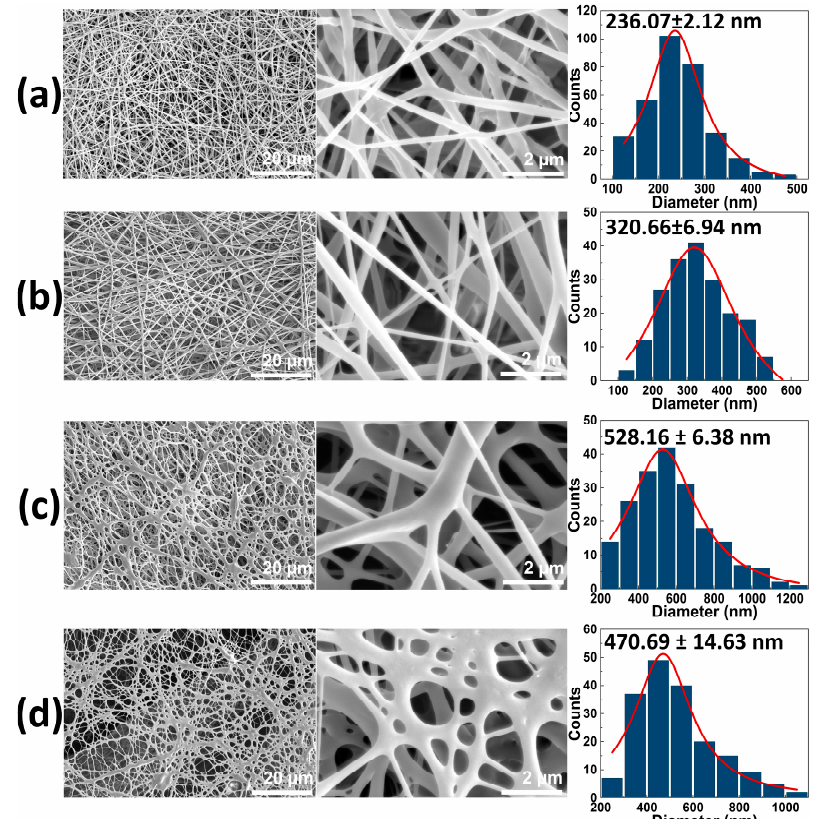
Figure 1. SEM images of ( a ) PLLA nanofiber, ( b ) 2.5 wt% CD/PLLA, ( c ) 5 wt% CD/PLLA, and ( d ) 10 wt% CD/PLLA nanofibers. The third column represents the histograms of size diameter distribution of the corresponding sample.